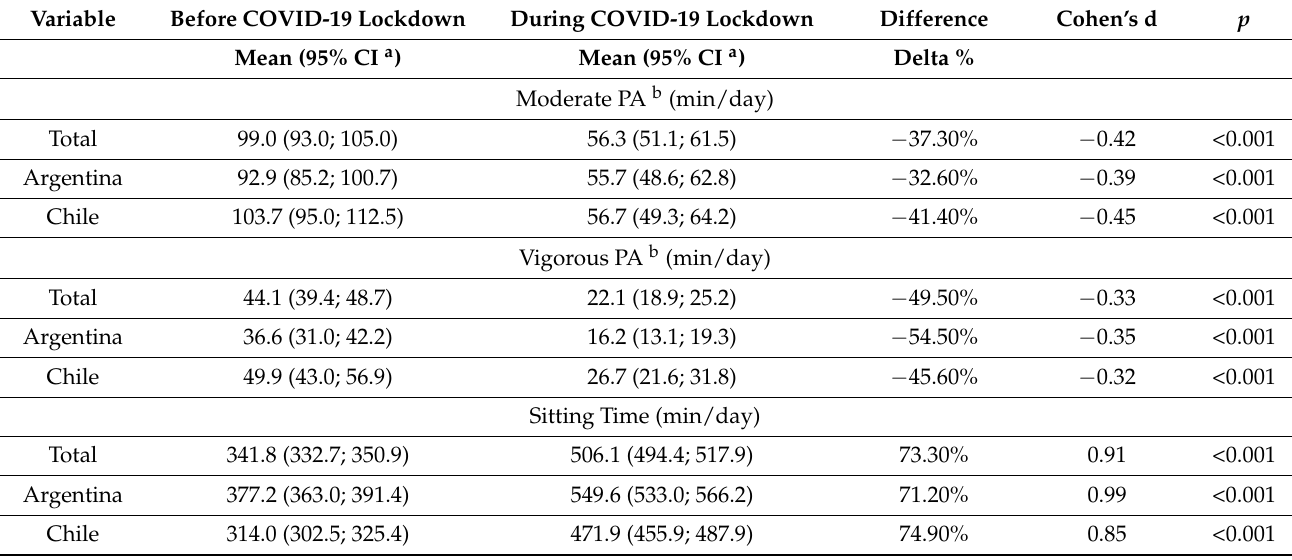
Table 2. Changes in physical activity, sitting time, and screen